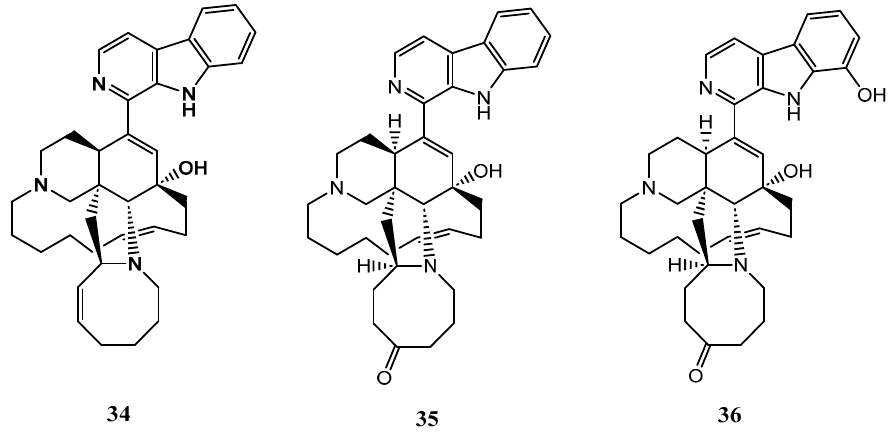
Figure 8. The chemical structures of manzamines A, E and F ( 34 - 36